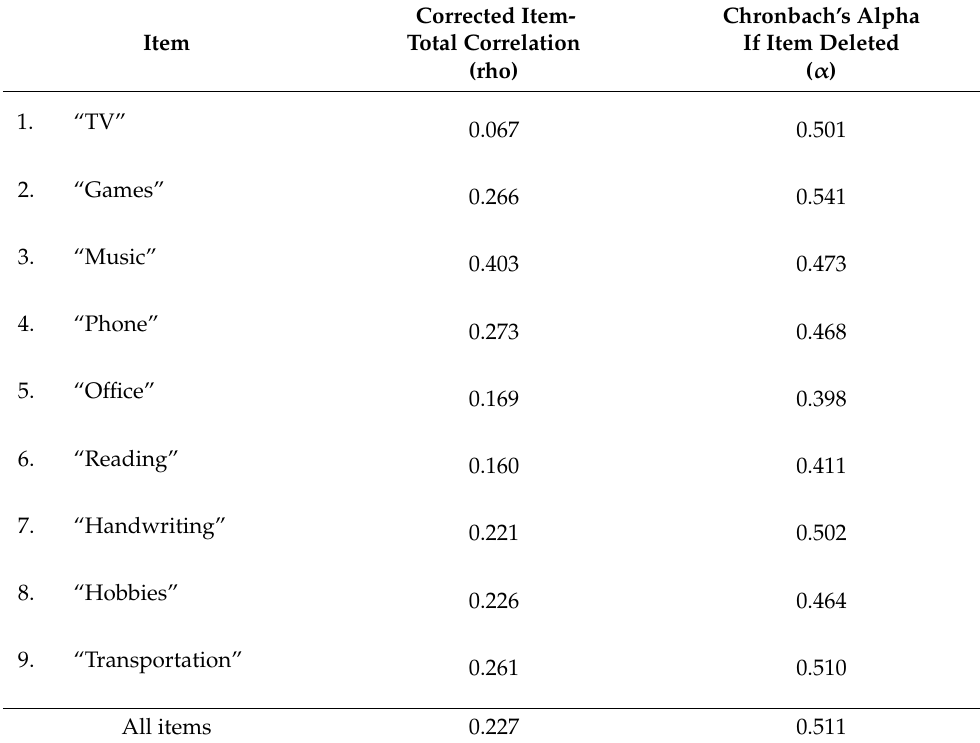
Table 3. Internal consistency and inter-item reliability of the mSBQ.